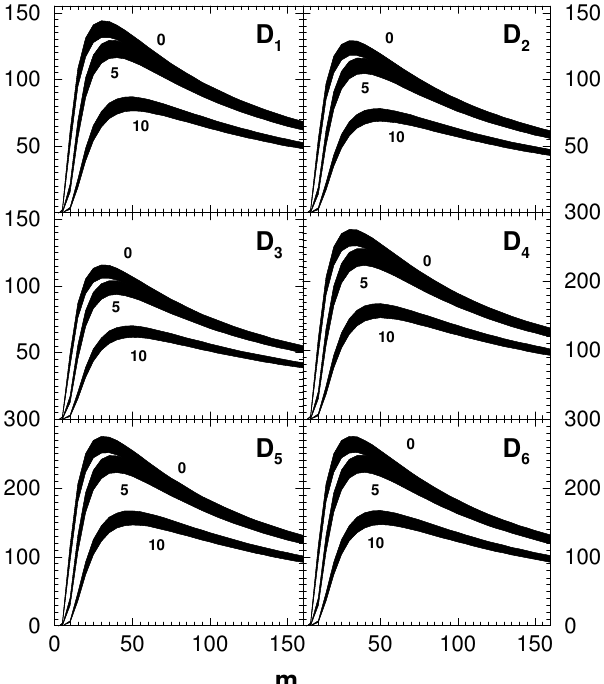
Figure 6. Nuclear structure coefficients plotted as a function of the Weakly Interacting Massive Particle (WIMP) mass in GeV for 23 Na. The graphs are plotted for three values of the detector threshold Q thr namely Q thr = 0,5,10 keV. The thickness of the graphs for each value of Q thr represents the annual